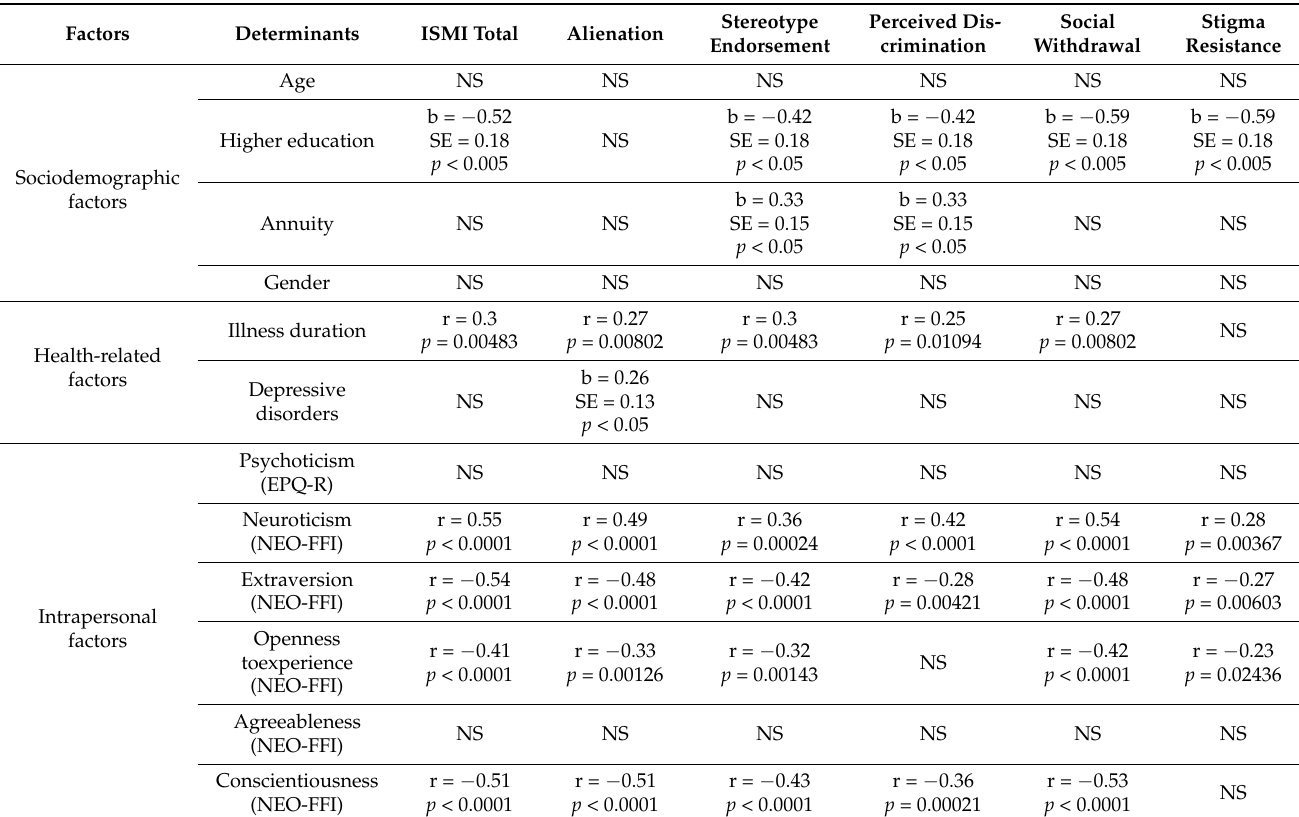
Table 3. Determinants of internalized stigma and its subscales among patients with severe mental illness using Spearman correlation for quantitative variables and univariate linear regression analysis for qualitative variables. Factors